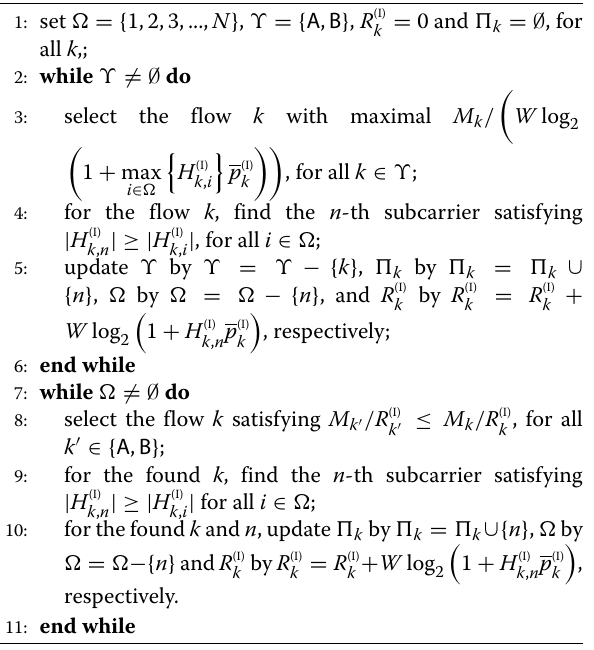
Algorithm 1 Subcarrier assignment algorithm for source phase